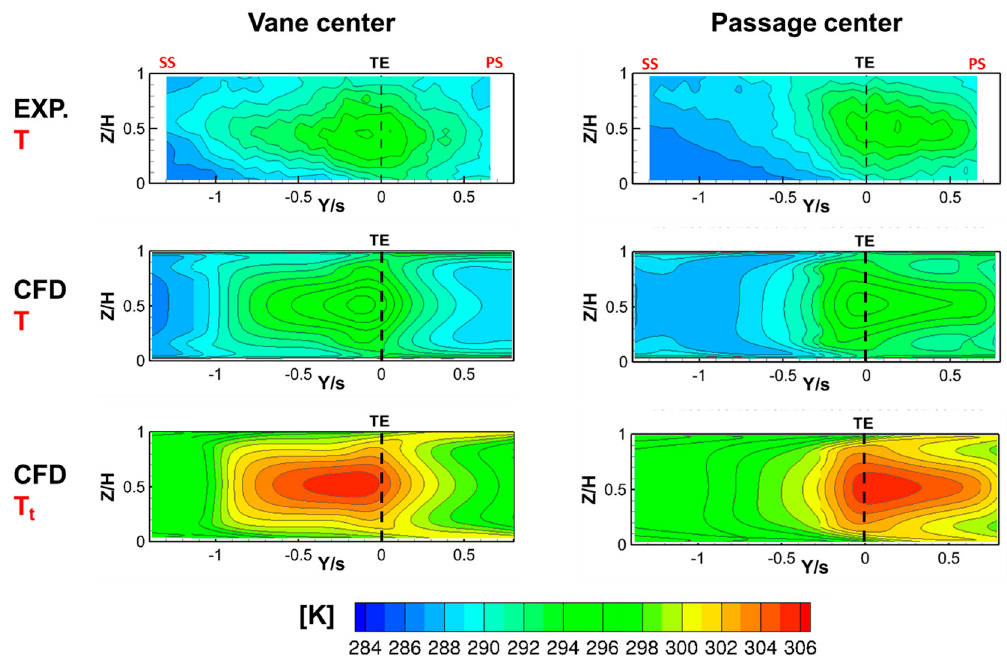
Figure 8. Comparison between experimental and predicted temperature fields at the vane exit plane ( X/C ax = 1.0) for the hot streak aligned with the vane or passage center. CFD: computational fluid dynamics.